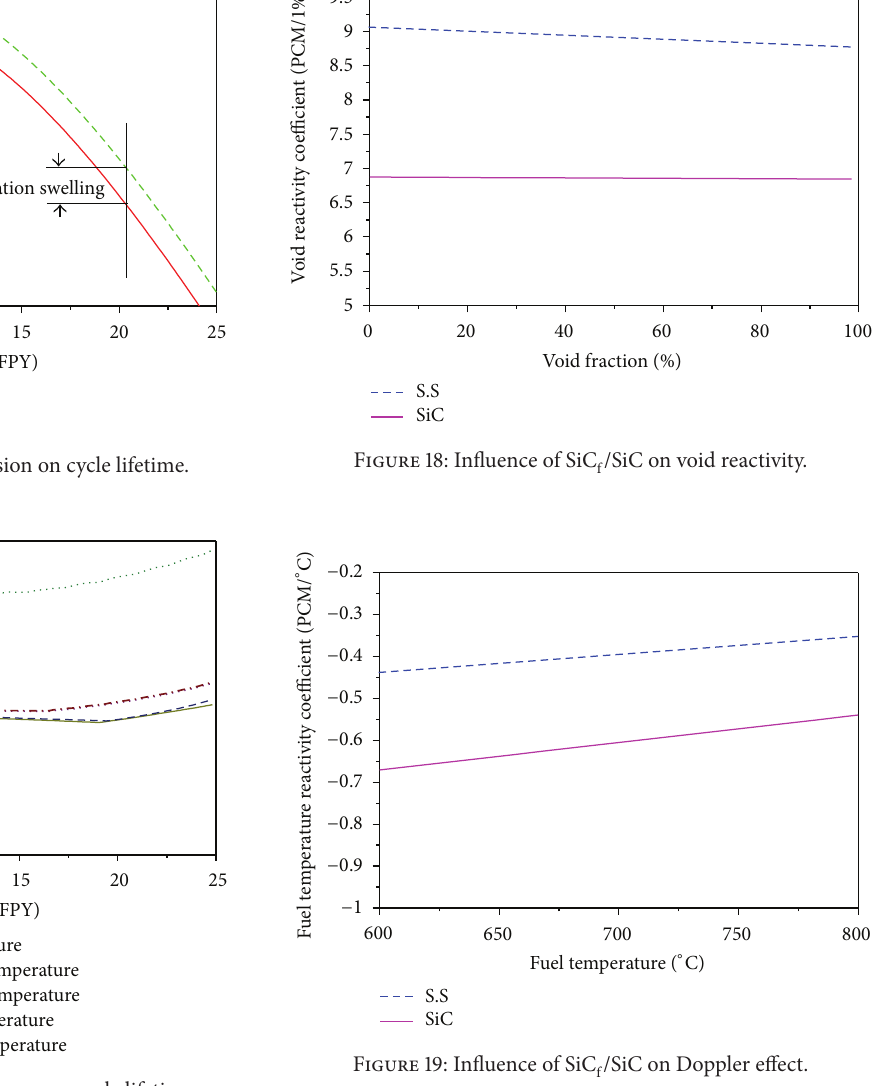
Figure 17: Rod peaking temperatures versus cycle lifetime.